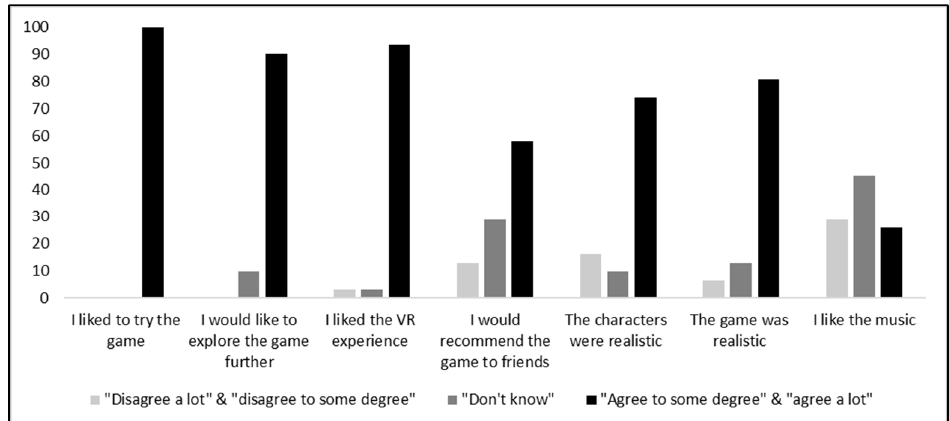
Figure 2. Game enjoyment of students in percentages ( n = 31).